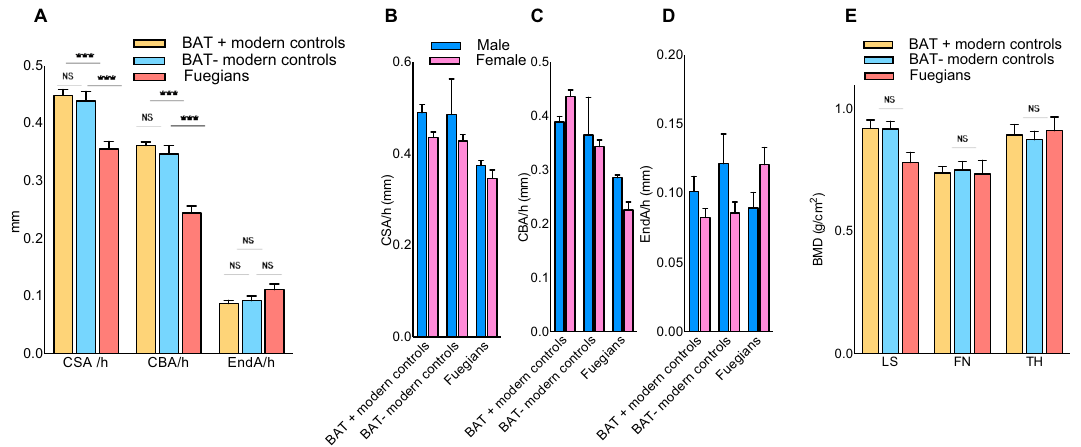
Figure. 1. Bone geometry and density comparison of a modern BAT+ and BAT− population living in a temperate area and cold adapted Fuegian skeletal remains. ( A ) Living subjects expressing Brown Adipose Tissue (BAT+) are not significantly different in terms of femoral geometry [height (h) standardized Cross sectional (CSA), Cortical Bone (CBA) and Endocortical Area (EndA)] compared to living subjects not expressing BAT (BAT−). Conversely, Fuegians CSA and CBA are lower, with EndA not being significantly different. ( B – D ) Height standardized CSA, CBA, and ENDa stratified by gender. ( E ) Living subjects expressing Brown Adipose Tissue (BAT+) are not significantly different in terms of bone mineral density (BMD) compared to living subjects not expressing BAT (BAT−) and the Fuegians at both lumbar and femoral level. LS, Lumbar spine; FN, Femoral Neck; TH, Total Hip; ***P < 0.001; ns, not significant.